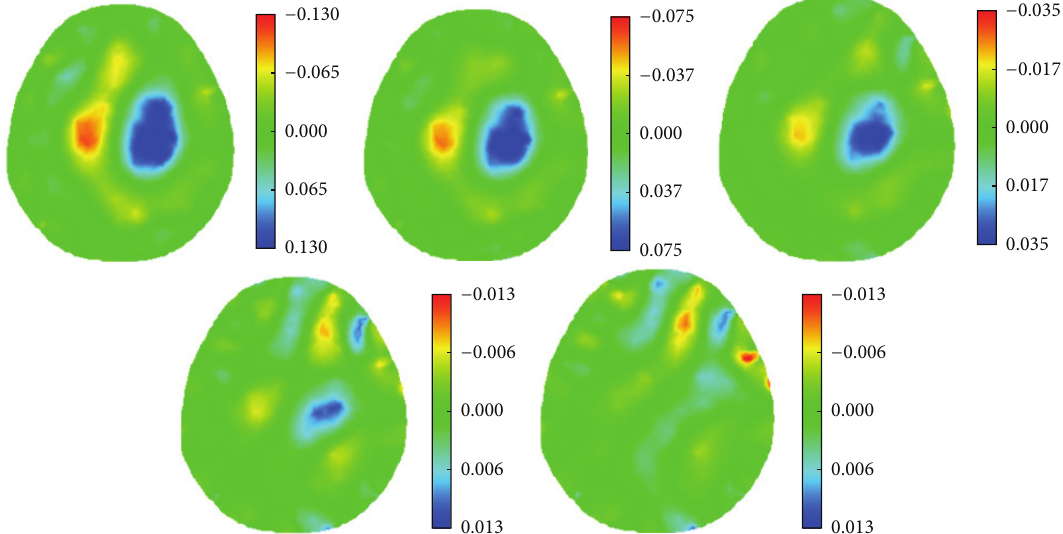
Figure 22: SEIT reconstructions of agar cylinders with radii of 2, 1.5, 1, 0.5, and 0.25 cm to simulate ischemic stroke lesions of different